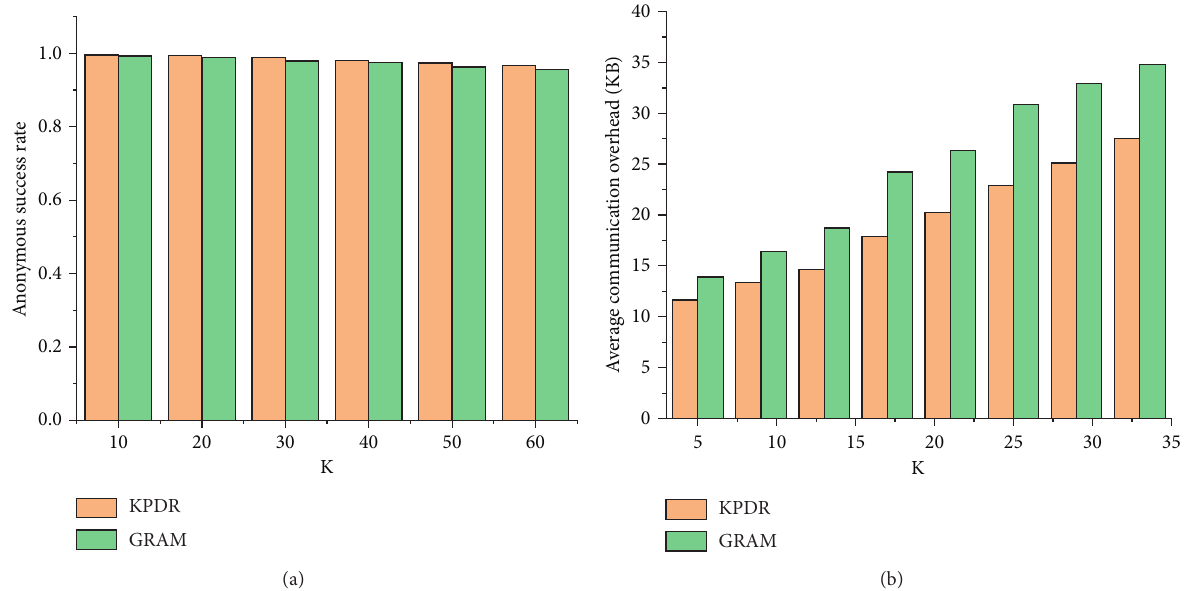
Figure 5: Average communication overhead. (a) Anonymous success ratio comparison. (b) Average communication overhead